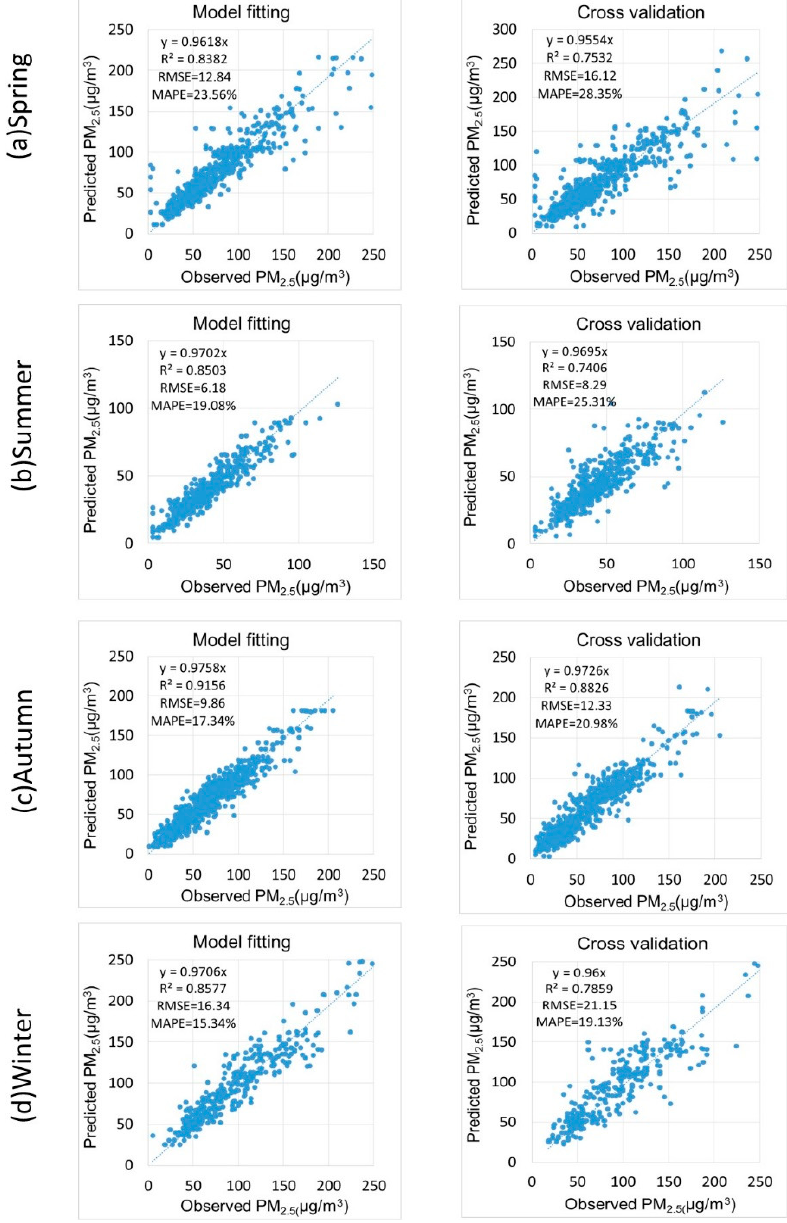
Figure 6. ( a – d ) Comparison between observed PM 2.5 and predicted PM 2.5 concentrations in the four seasonal models. The dashed lines are regression lines.